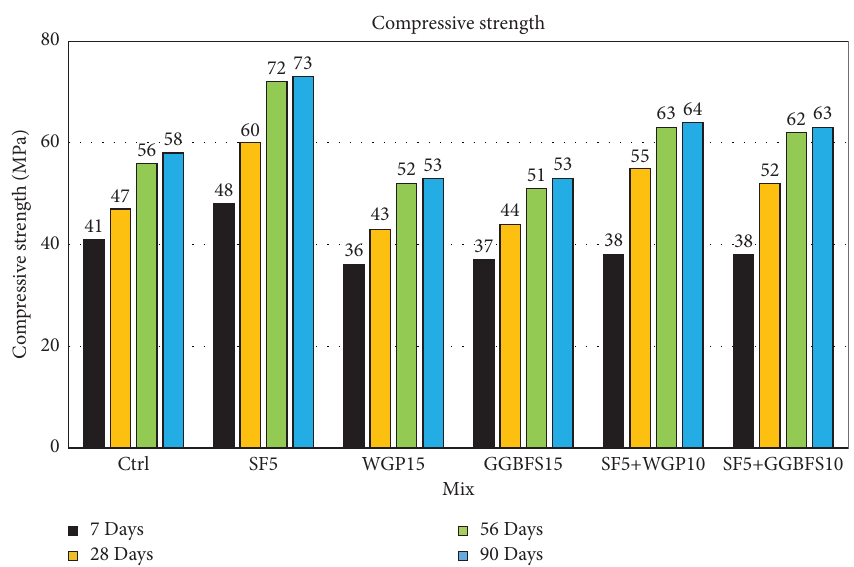
Figure 5: Compressive strength results of concrete mixtures.